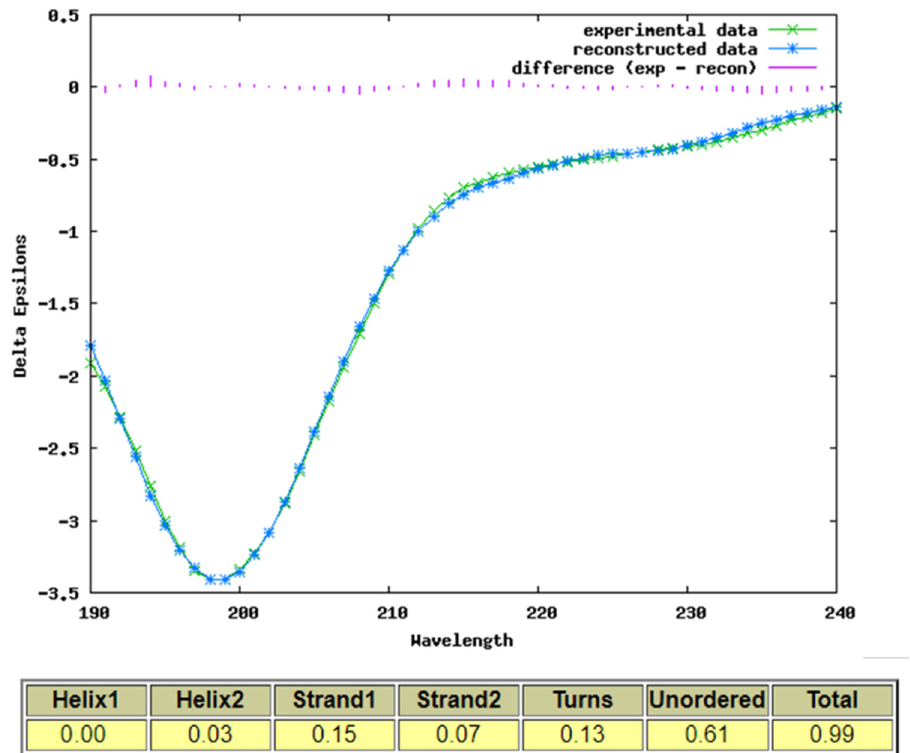
Figure 5. Circular dichroism of the Sox-2 iPep: CKRLRALH-Nle-KEHPDYKYRPRRKTKT. CD spectrum of the Sox-2 iPep at 50 µM concentrations in 50 mM PB, pH 7.4 at 4C reveals that there is no helical content and, instead of that, the peptide has beta-strand content (~22%), and the rest is a random coil.